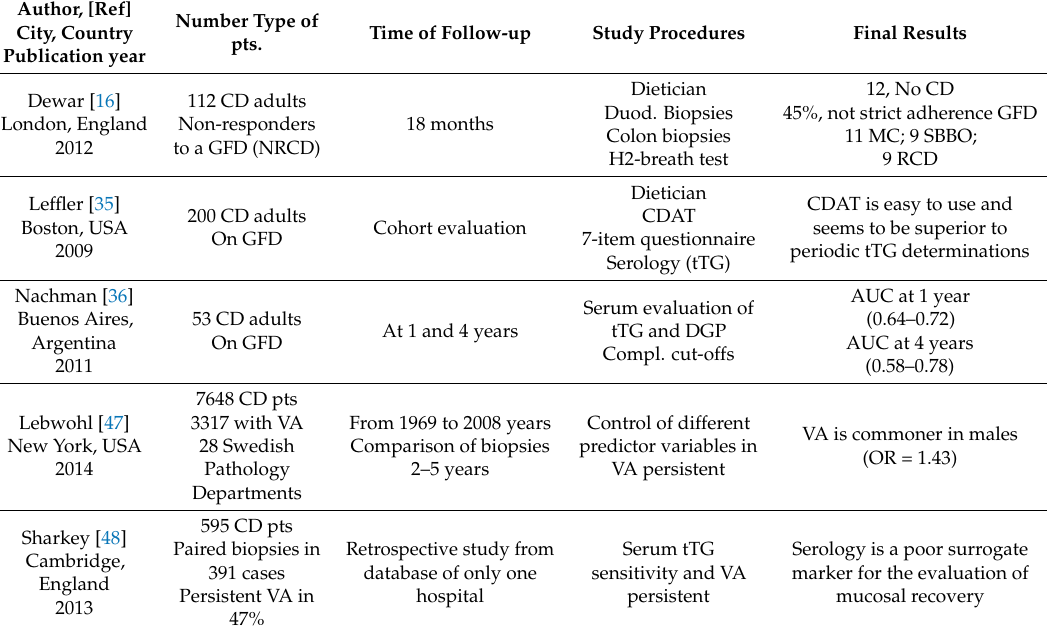
Table 1. Summary of studies looking to GFD adherence and efficacy using various